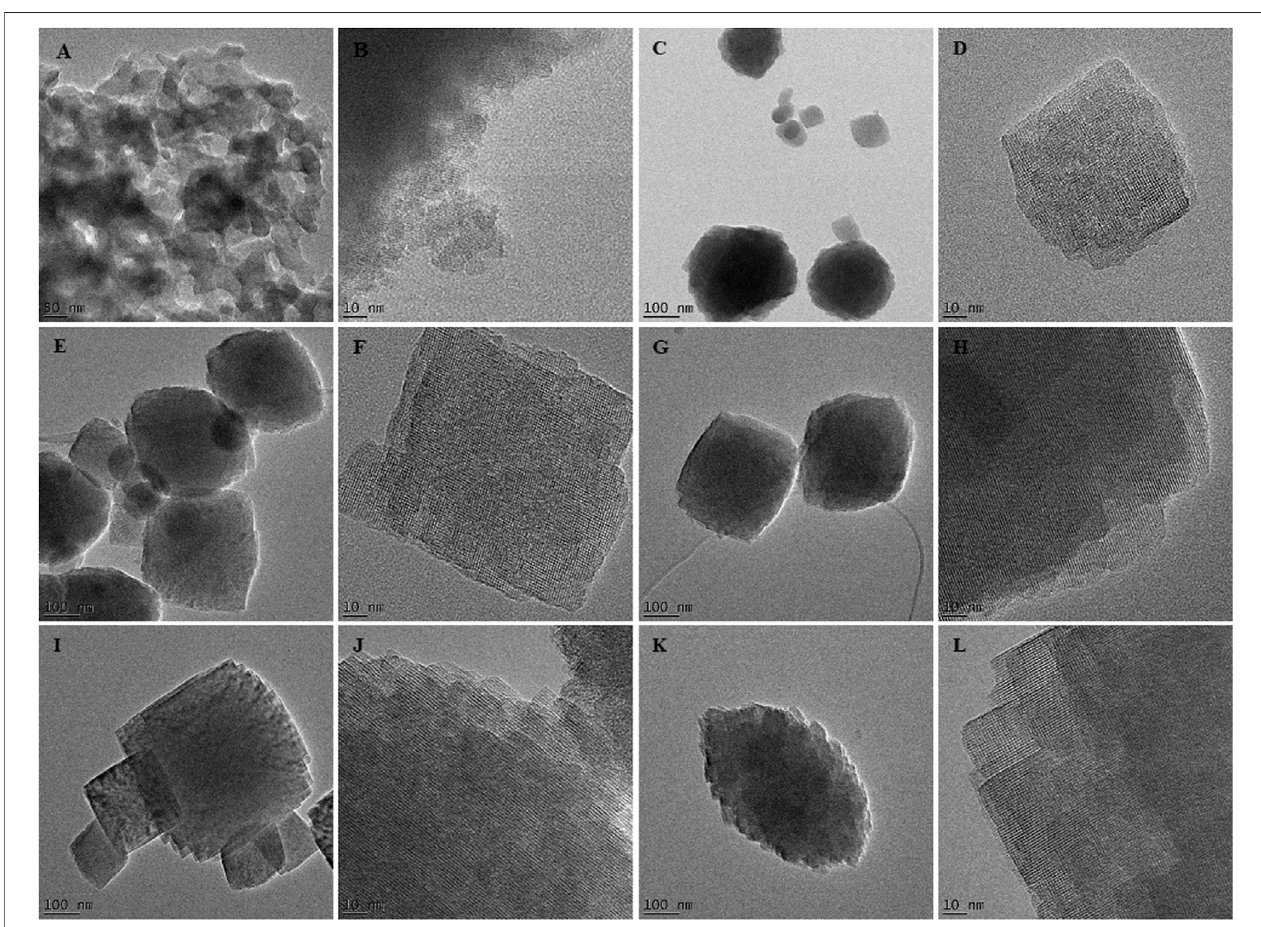
FIGURE5 | TEMimagesofthe as-synthesized HBEA zeolites H8 (A,B), H10 (C,D), H12 ( E,F), H24 (G,H), H48 (I,J), and H72 (K,L) produced from CFA nanosilica extract at different water contents and hydrothermal times.